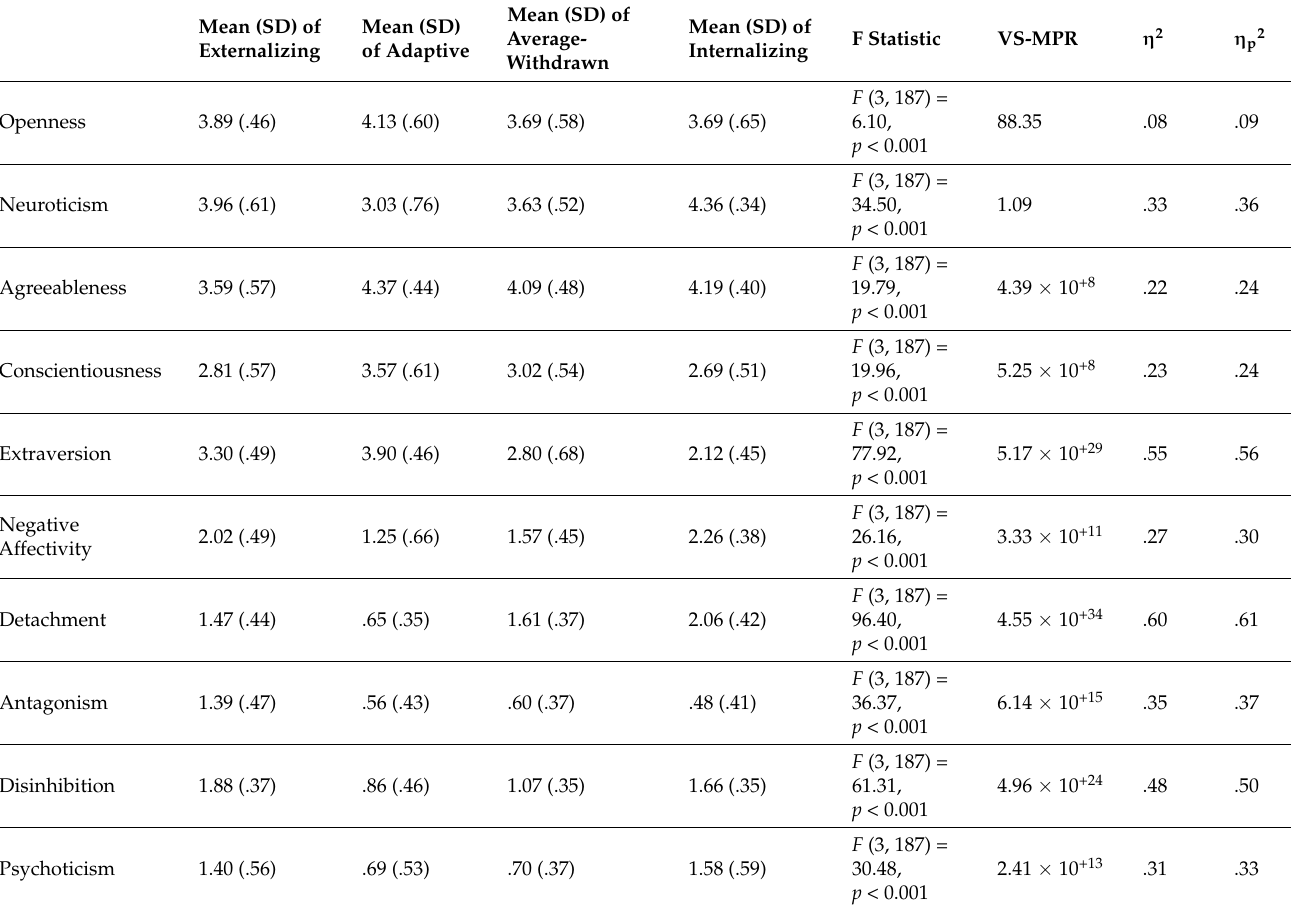
Table A3. Means, Standard Deviations, ANCOVA F statistic, Vovk-Sellke Maximum p-Ratio, and eta squared of FFM–AMPD Combined